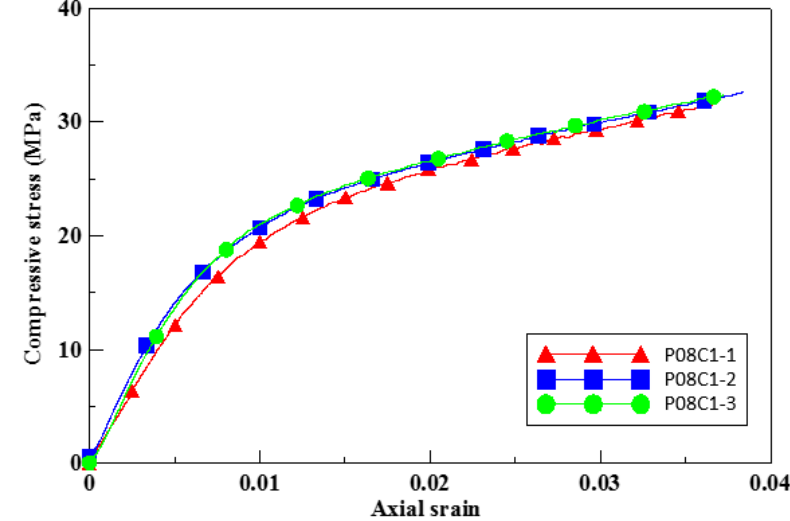
Figure 8. The illustration photo of compression test for cylindrical specimens P08C1.